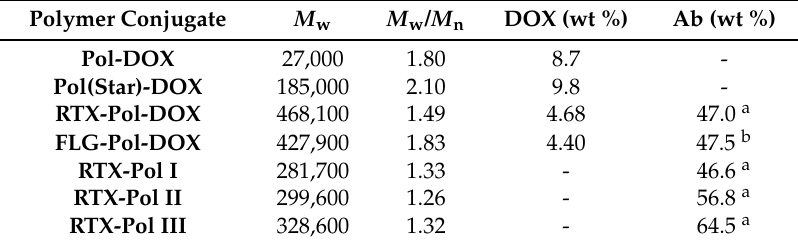
Table 2. Characteristics of polymer-drug and polymer-Ab